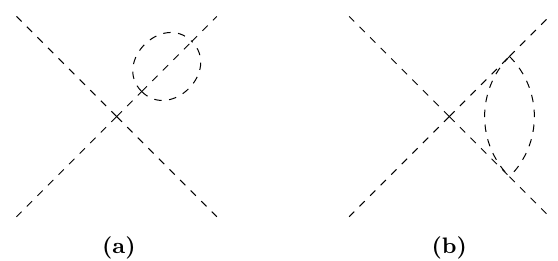
Figure 13. ( quartic 3 ) contributions to the two-loop beta function of quartic couplings.